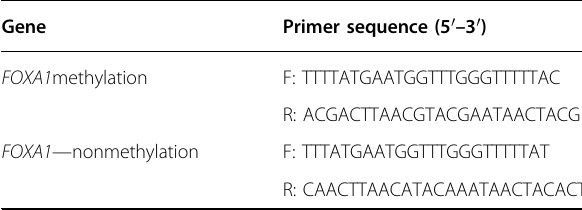
Table 2 Primer sequence for methylation-speci fi c PCR Gene Primer sequence (5 ′ – 3 ′